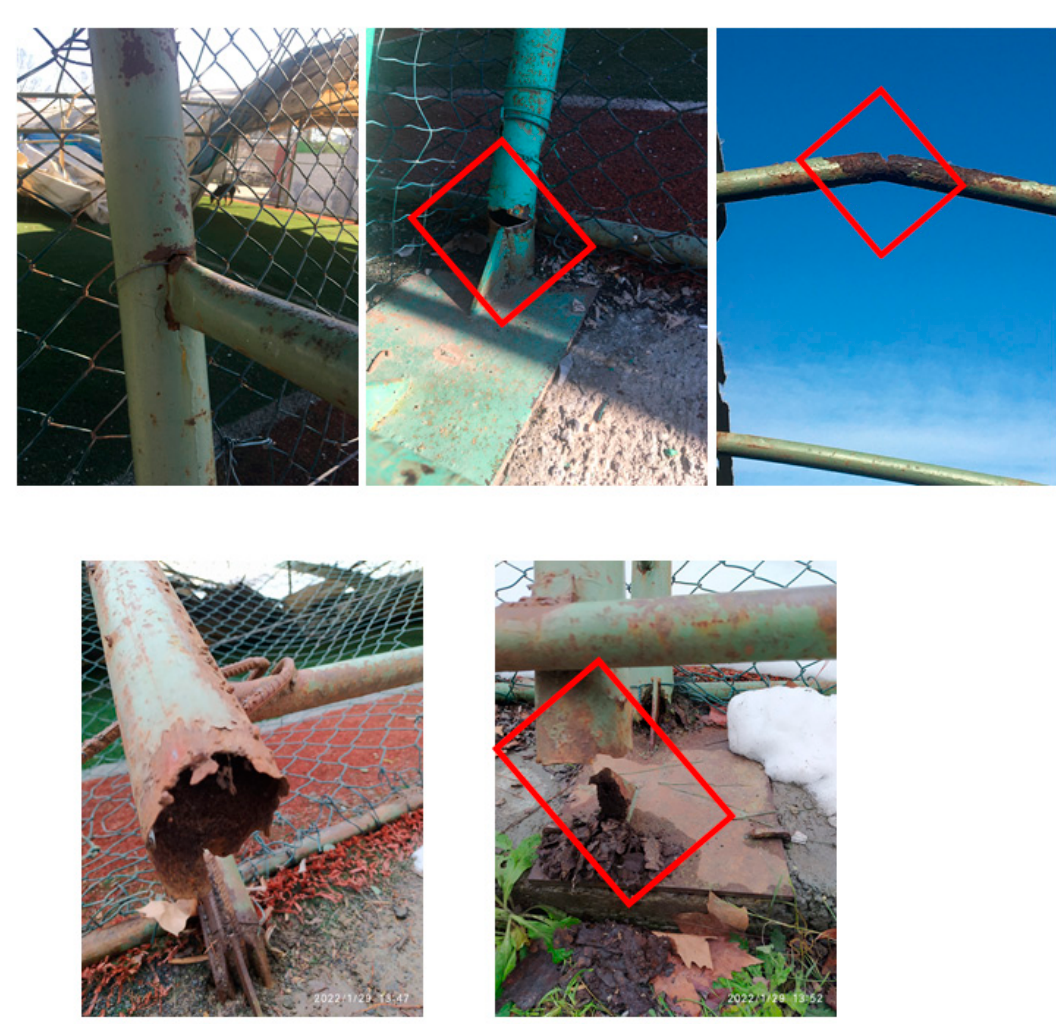
Figure 8. Corrosion damage to structural members.